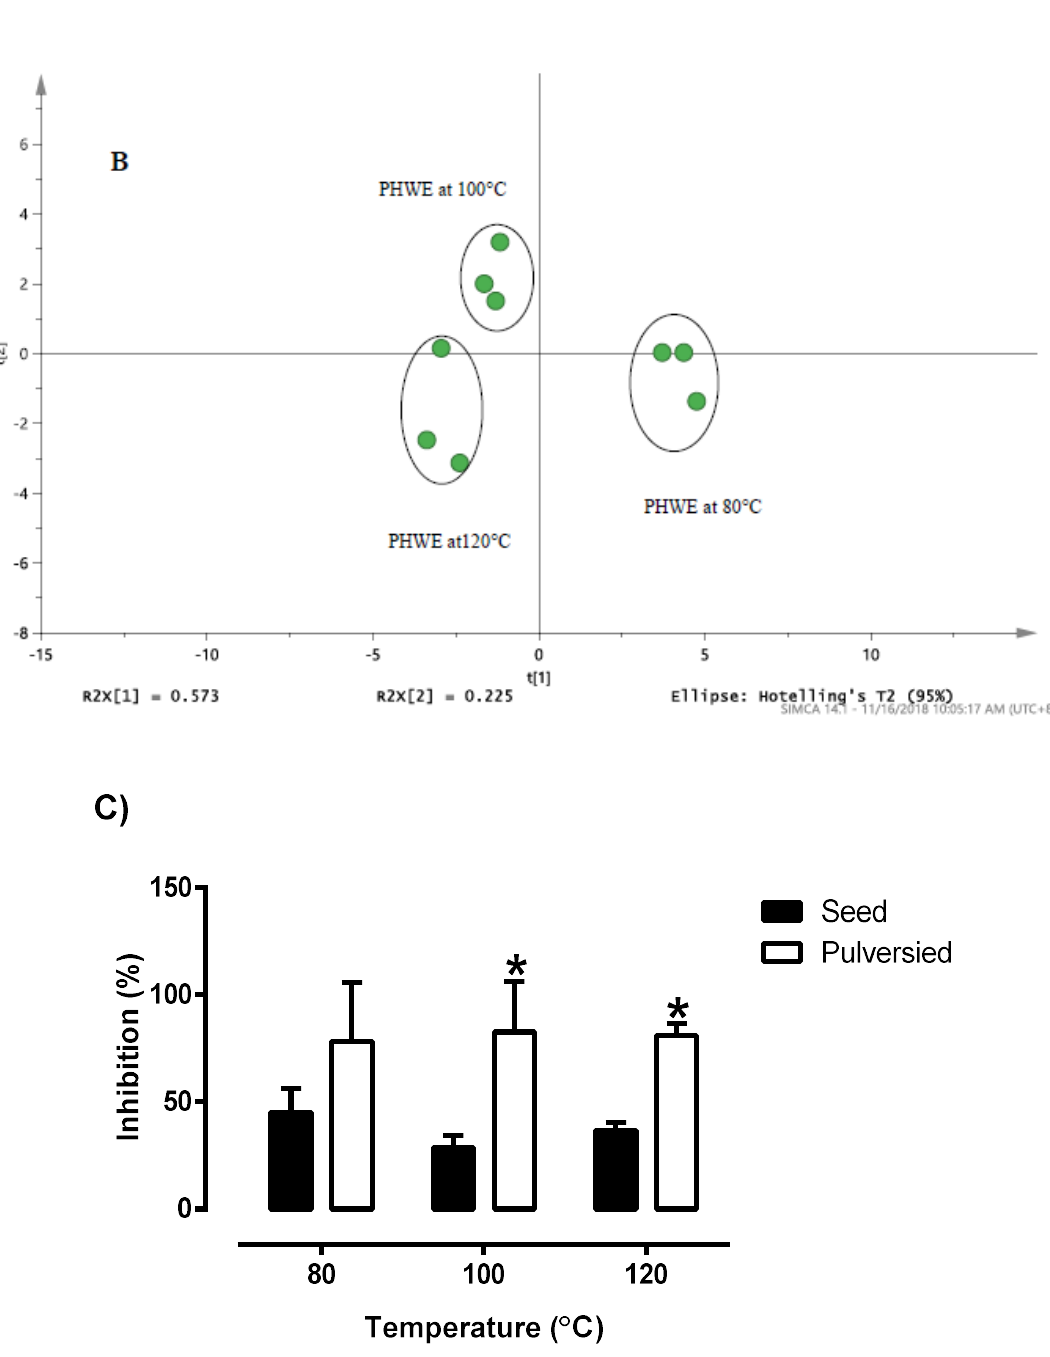
Figure 3. The PCA score plot of ( A ) LC/MS profile for white Bolivia seed derived from Table 1. ( B ) LC/UV profile for white Bolivian quinoa seed detected at 280 nm. ( C ) Radical scavenging activity of pulverised and non-pulverised white Bolivian quinoa seeds extracted at 80, 100 and 120 °C. * Significant difference between the whole seeds and pulverized seed at a given temperature (Students’ unpaired t -test). Results are mean ± SD ( n = 3) with the significance accepted at p ≤ 0.05.